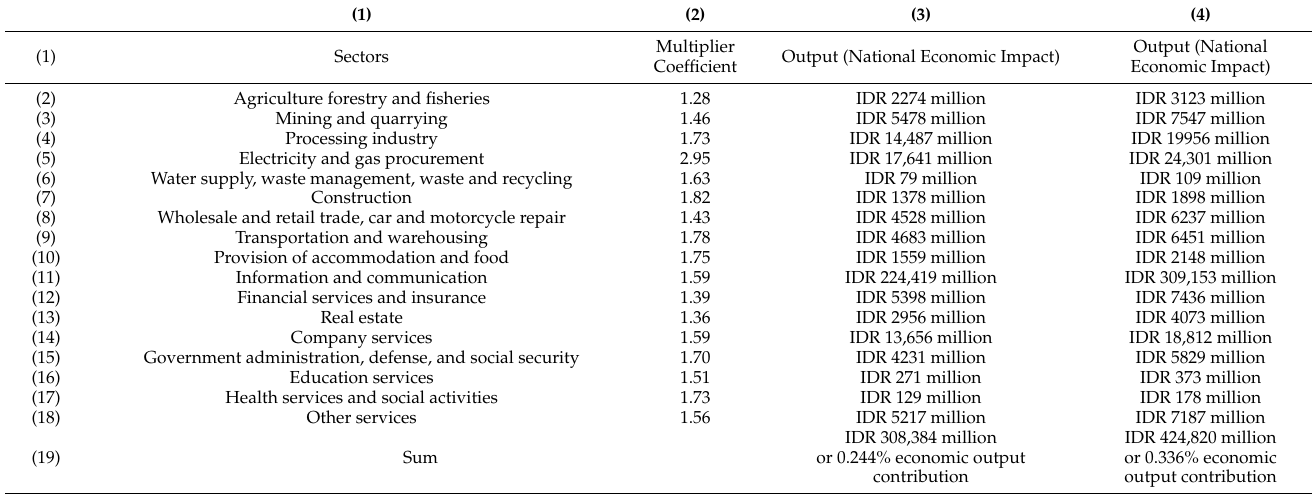
Table 7. Multiplier coefficient and economic impact from 5G-mmWave private network deployment investment (Million